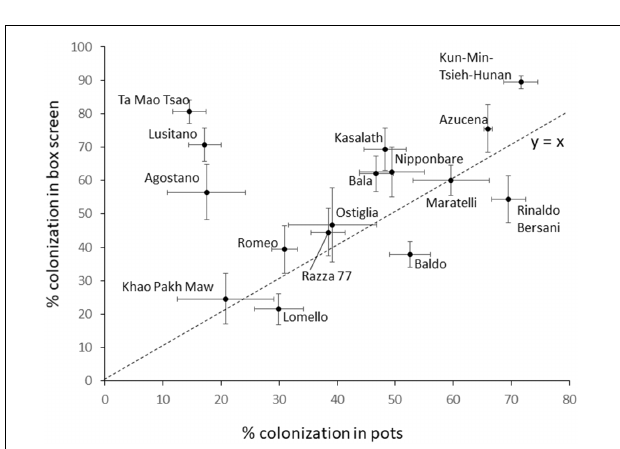
FIGURE 7 | Frequency distribution of mean hyphal colonization in the Rice Diversity Panel 1 cultivars highlighting values of some notable cultivars. ∗ for Azucena and Bala indicates these are the Aberdeen “own” genotypes for these cultivars. The font used for cultivars indicate subpopulation; normal = indica, underlined = temperate japonica, italic = aus, bold = tropical japonica.